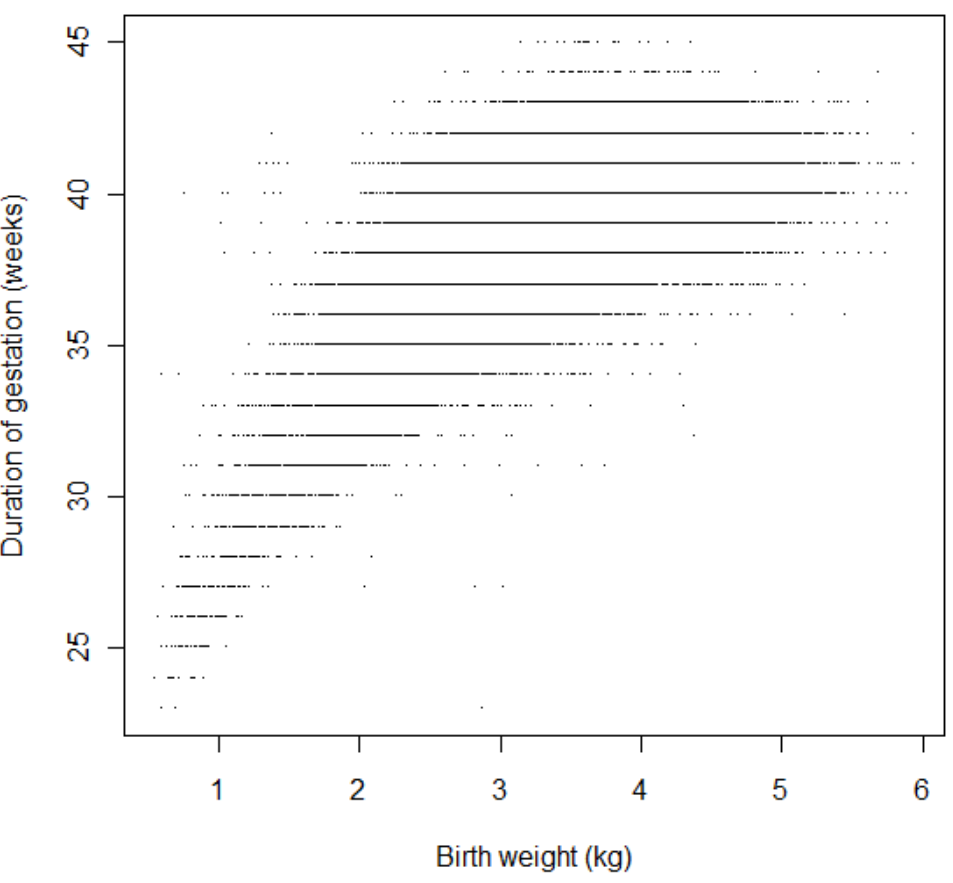
Figure 2. Duration of gestation plotted against birth weight.